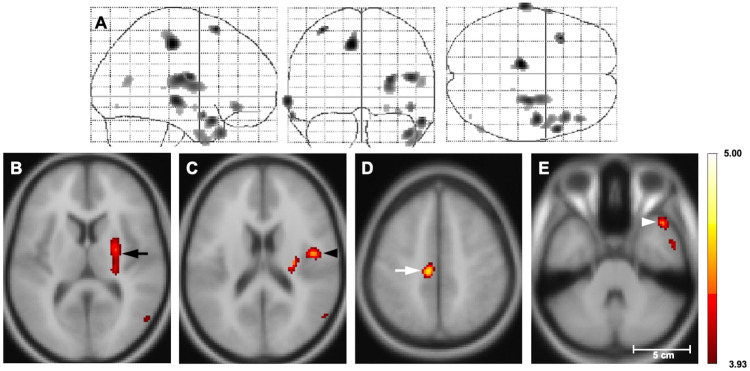
Statistical nonparametric T map of rCBF reduction in the OCD patients vs. healthy controls.(A) The three orthogonal planes represent a maximum intensity projection (MIP) ‘glass brain’. (B–D) Selected planes show results superimposed on MNI152 T1 template. Color bar: Student’s T-values. Significant reductions of rCBF are observed in the right putamen (black arrow), right frontal operculum (black arrowhead), left midcingulate cortex (white arrow), and right temporal pole (white arrowhead) in the OCD patients compared to the controls (thresholded at T > 3.93, p<0.05 with the family-wise error rate correction for multiple comparisons in the SnPM analysis). There were no areas of increased rCBF in the OCD patients (data not shown). rCBF, regional cerebral blood flow; OCD, obsessive-compulsive disorder; SnPM, statistical nonparametric mapping.